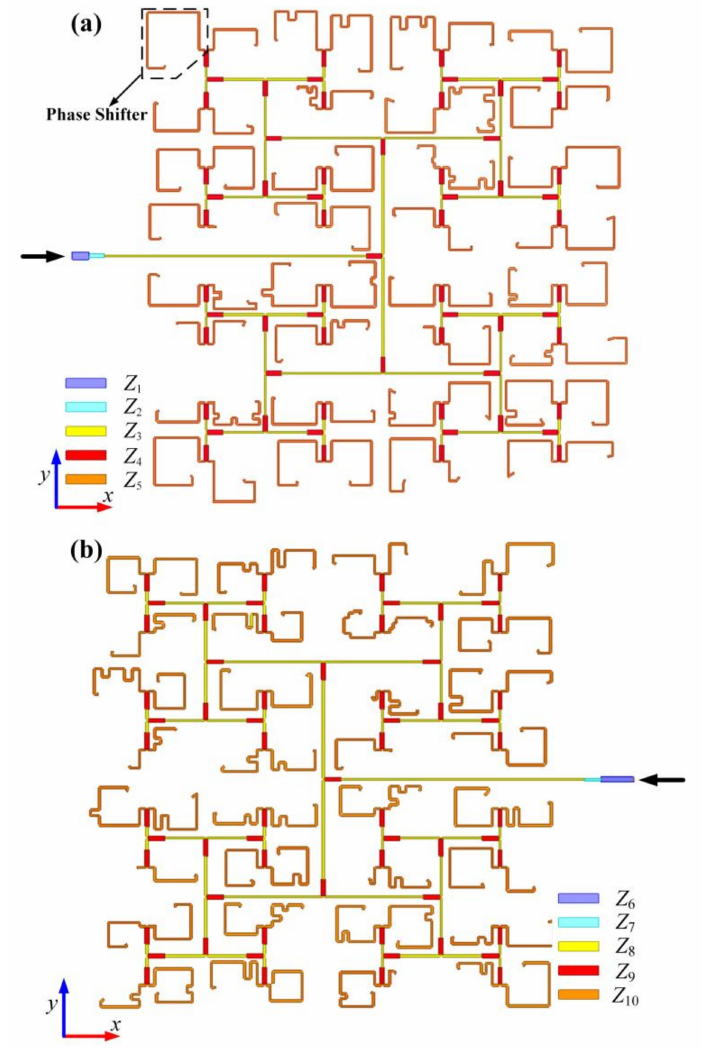
Figure 6. Layouts of the ( a ) upper and ( b ) bottom feeding network for the quad-vortex-beam array in Case